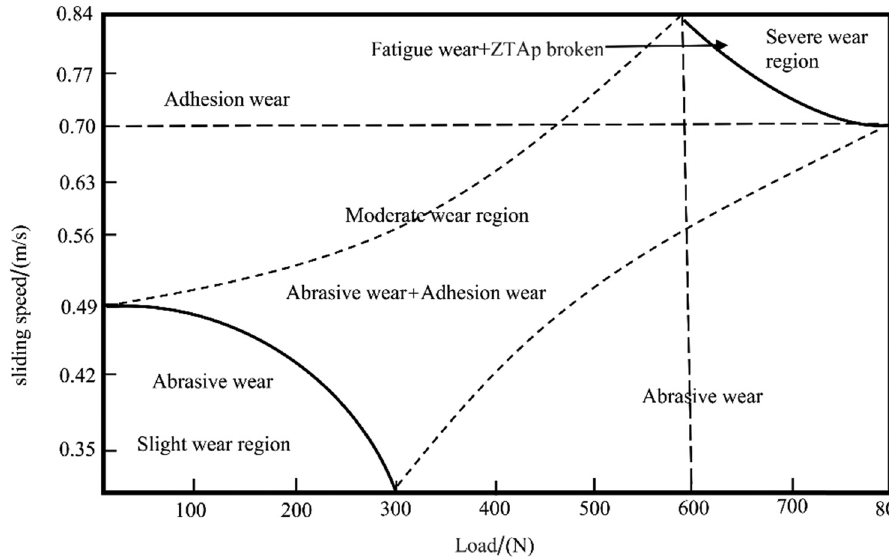
Figure 9: Wear mechanism diagram of